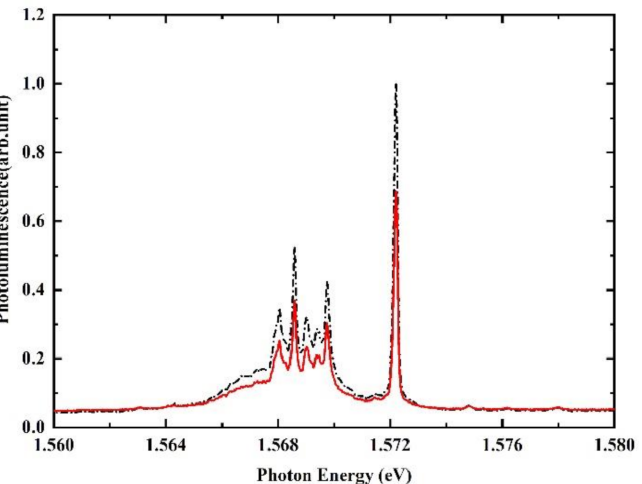
Figure 3. Spectra collected at positions of the quantum dot (black dash line) and out-coupler at the end of the waveguide (red